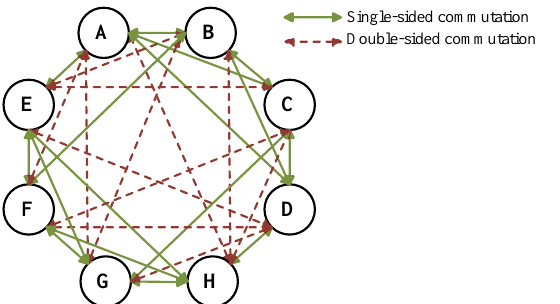
Figure 5. Commutation process of back-to-back converter. (The meanings of A, B, C, D, E, F, G, H, are shown in Figure 4.)